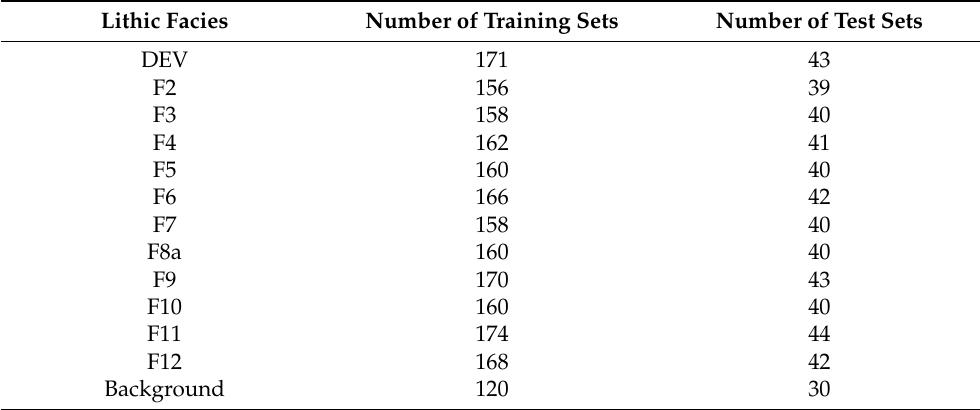
Table 1. Quantity of training set and test set.